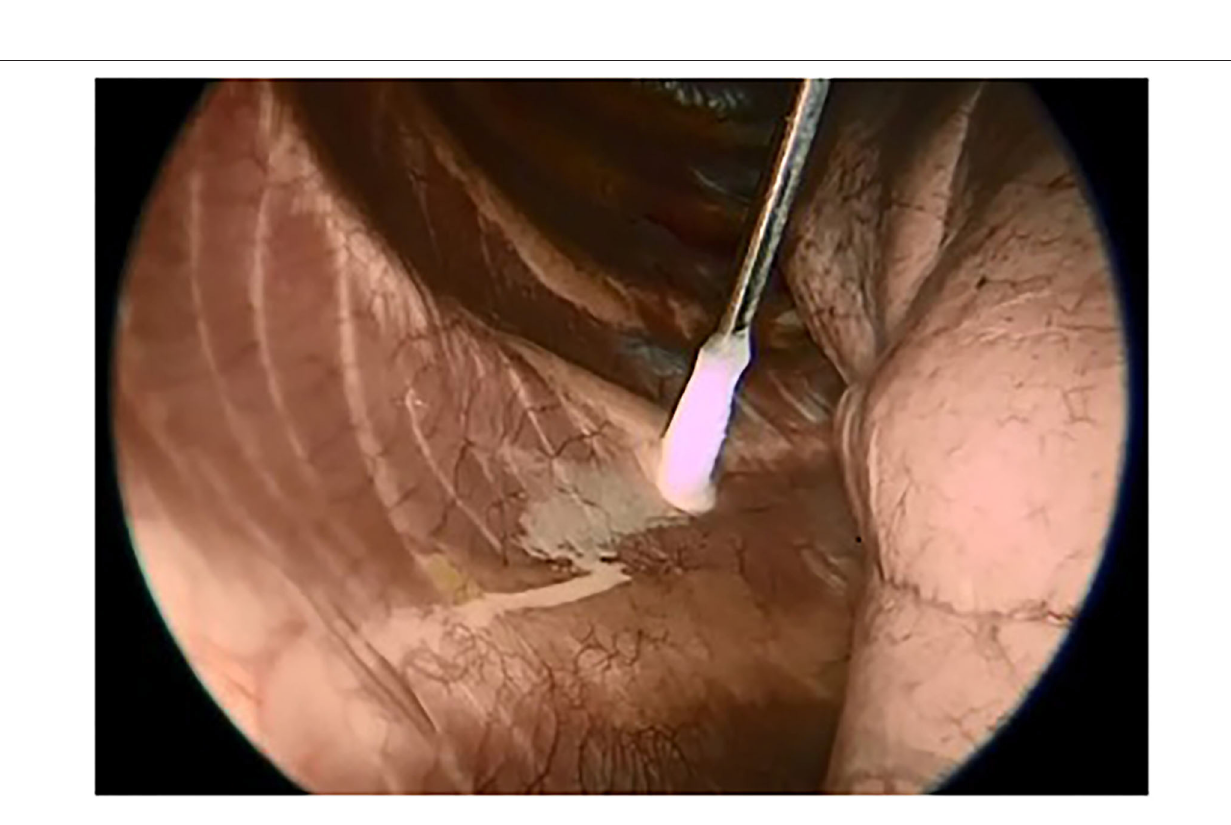
FIGURE 2 | Thoracoscopic view of the ice